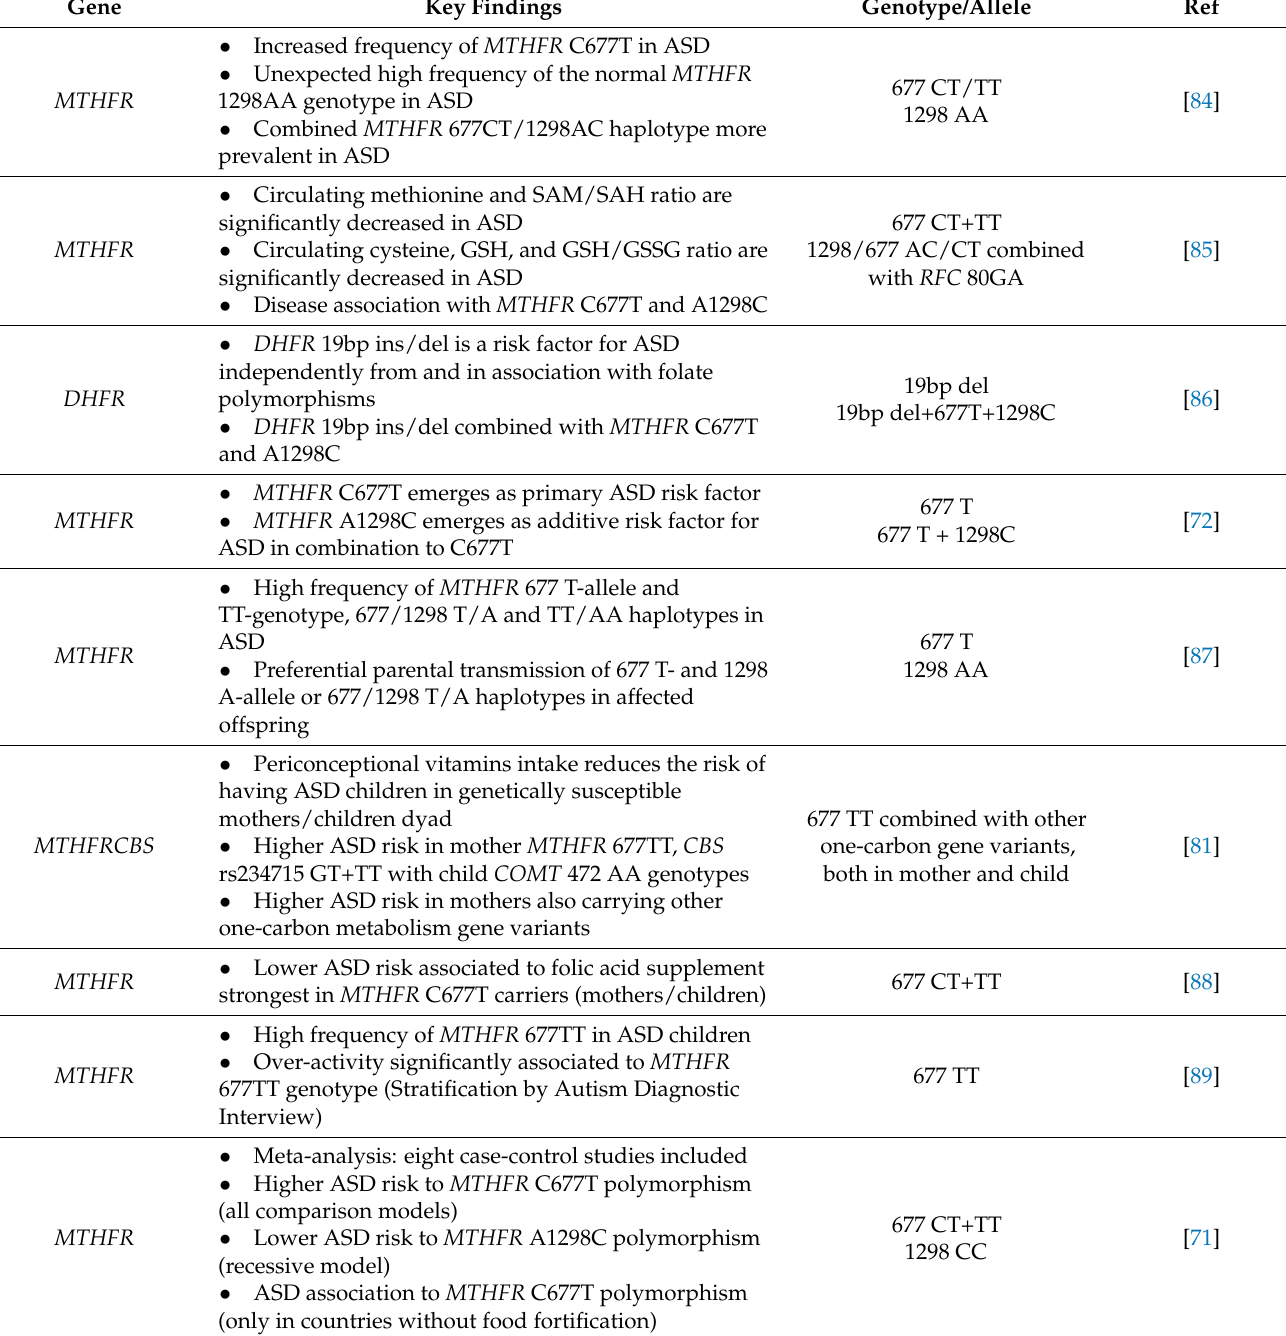
Table 1. Selected Studies on MTHFR , DHFR and CBS Genes Reporting Significant Associations with ASD. Gene Key Findings Genotype/Allele